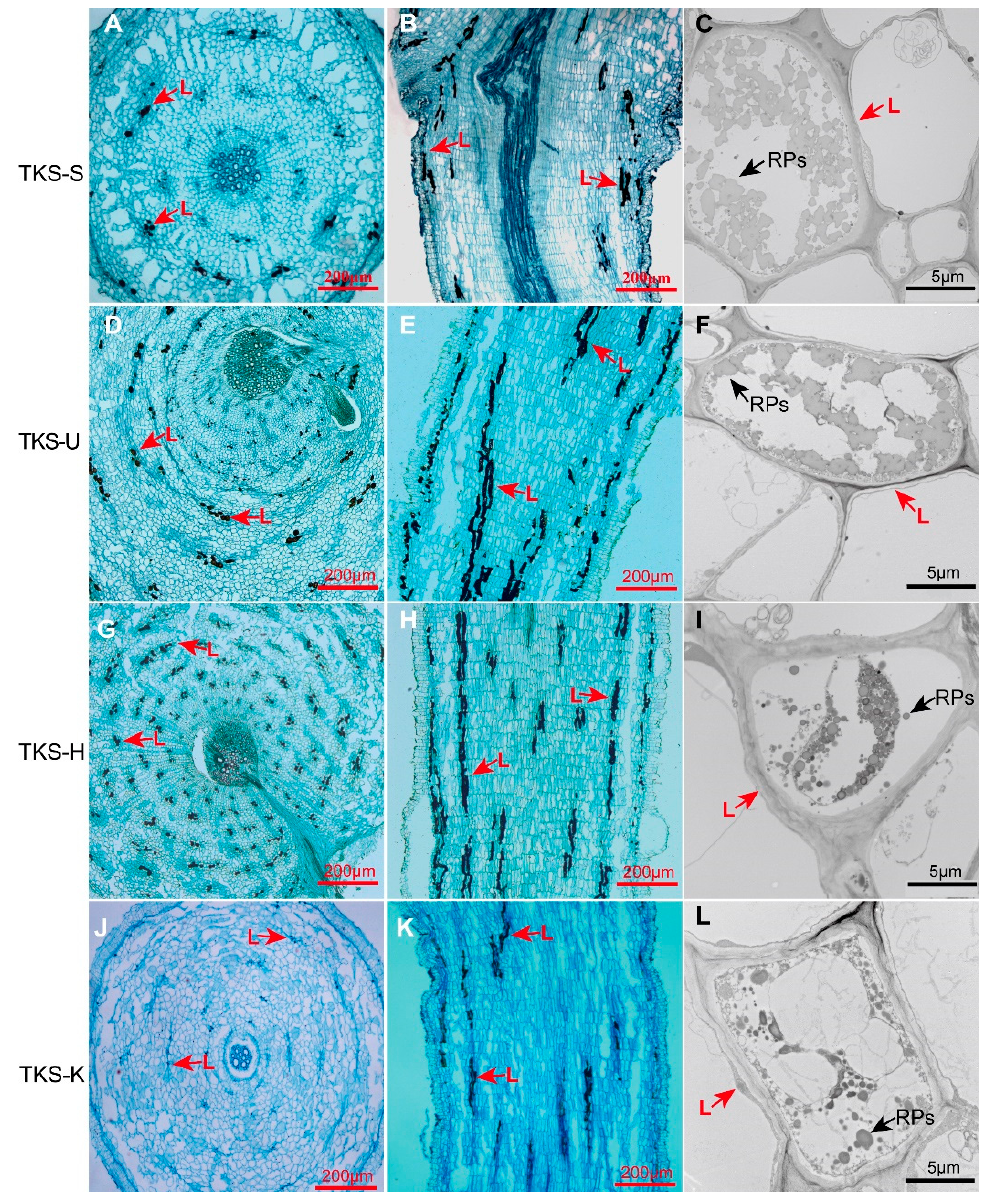
Figure 4. Comparison of rubber particles and laticifer cells in the old roots of different T. kok-saghyz varieties. Distribution of laticifer cells in the cross-cutting ( A , D , G , J ) and longitudinal sections ( B , E , H , K ) in old roots of four TKS varieties were highlighted, and rubber particles in their laticifer cells were further examined under a TEM ( C , F , I , L ) in TKS-S ( A – C ), TKS-U ( D – F ), TKS-H ( G – I ), and TKS-K ( J – L ).